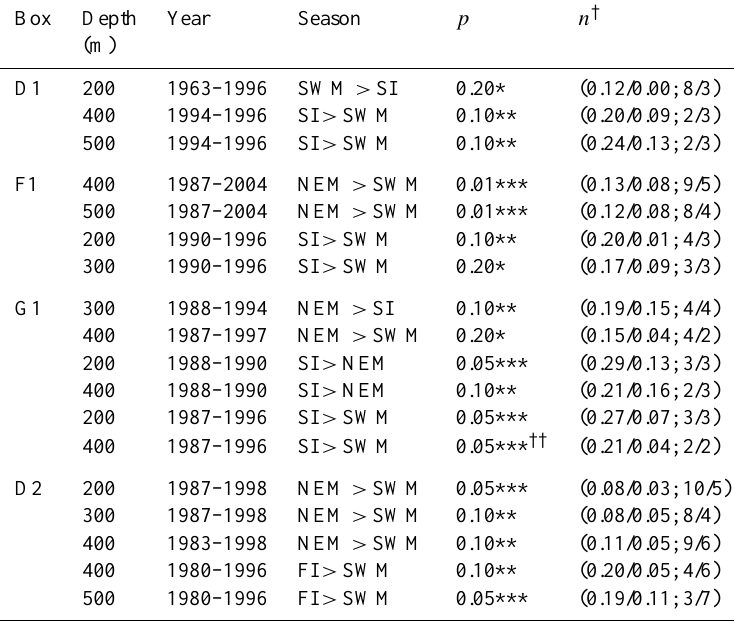
Table 4. Significant seasonal differences in median O 2 concentrations (mLL − 1 ) in the OMZ for boxes and depths with ≥ 2 values during similar periods. One-sided p : *, ≤ 0.20; **, ≤ 0.10; ***, ≤ 0.05. See Fig. 3 for names of seasons and months.